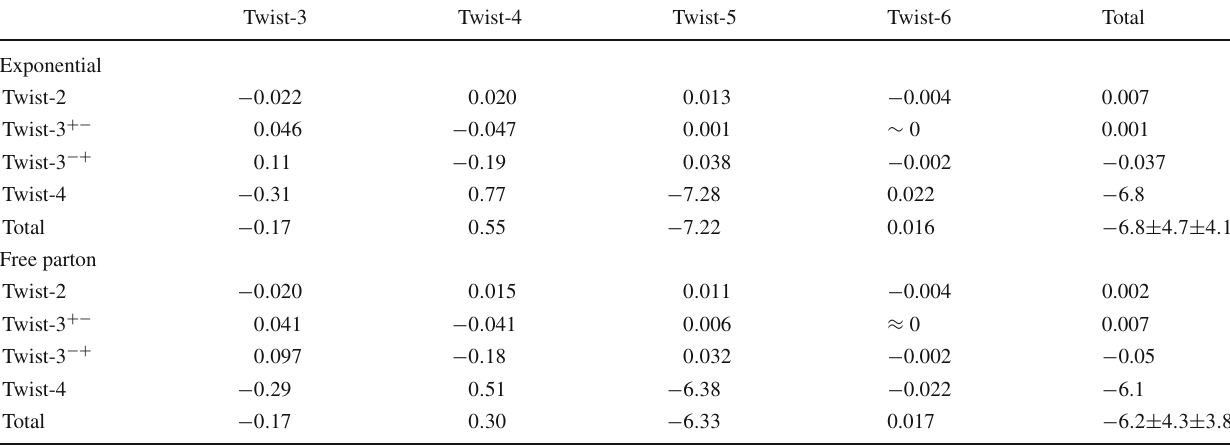
Table 8 The same as Table 4 but for the form factor f 3 ( 0 ) in unit of 10 −